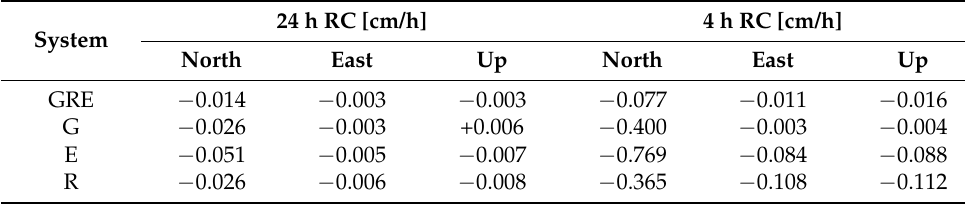
Table 7. The slope regression coefficient for mean NEU